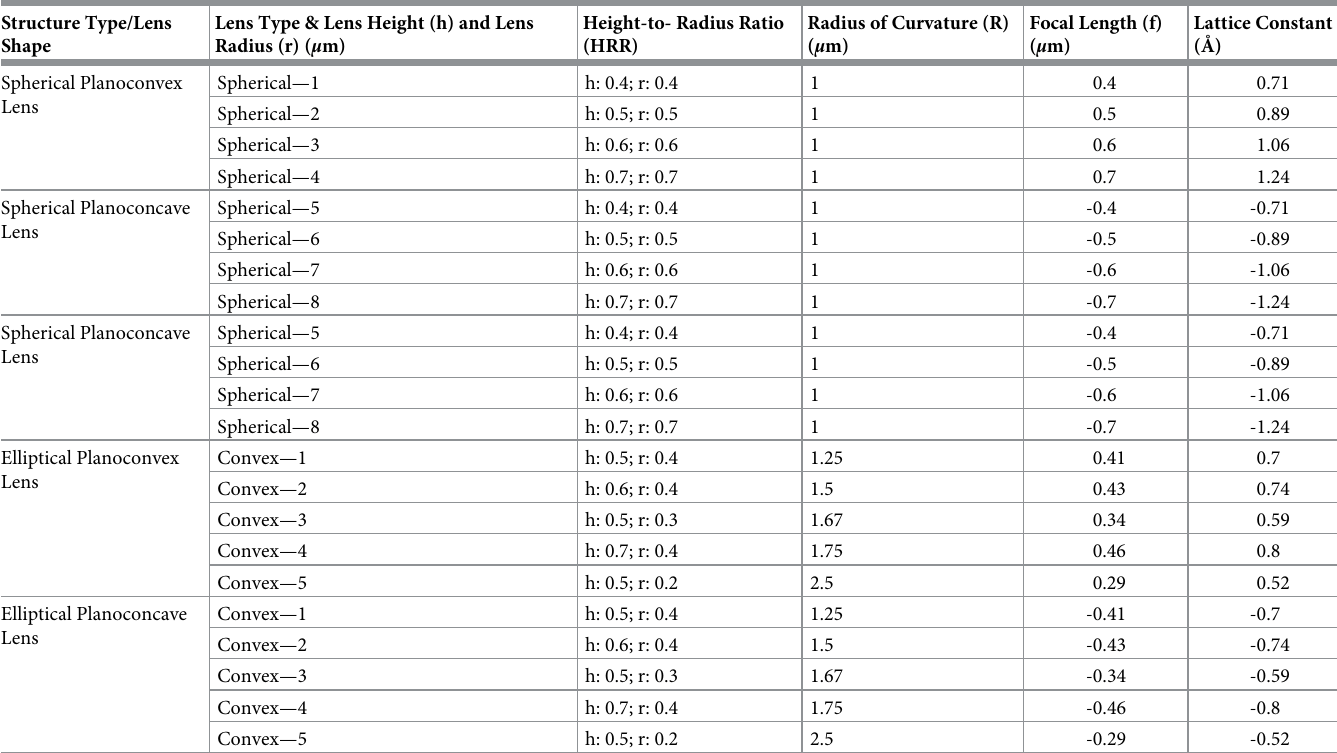
Table 2. Physical properties of several layers of OLEDs [29]. Structure Type/Lens Lens Type & Lens Height (h) and Lens Shape Radius (r) ( μ